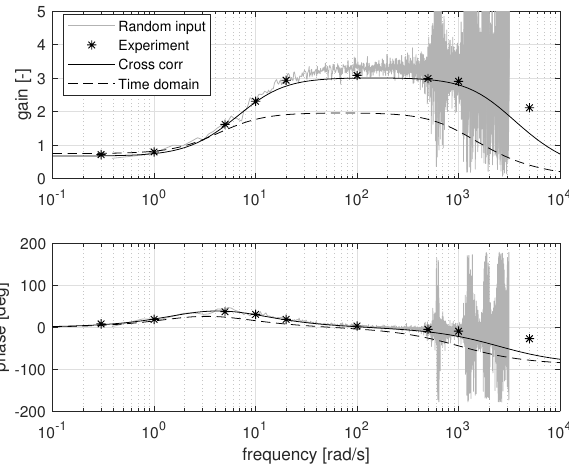
Figure 16. Bode plot of δ i ∗